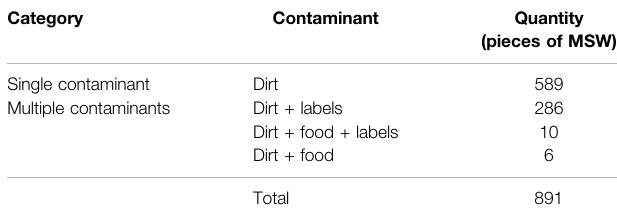
TABLE 2 | Quanti fi cation of mixed plastic contaminants.